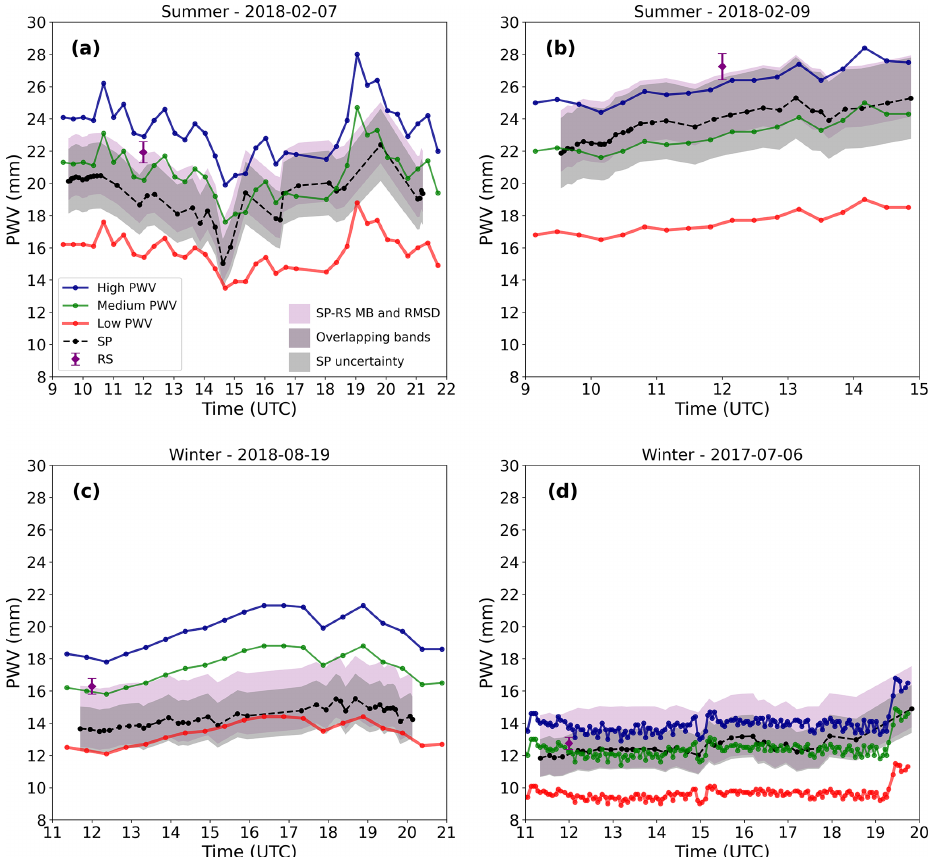
Figure 7. Examples of ASIVA PWV retrieval time series using synthetic profiles compared to AERONET sun photometer (SP, black) and radiosonde (RS, purple) for two summer days, ( a ) 7 February 2018 and ( b ) 9 February 2018, and two winter days, ( c ) 19 August 2018 and ( d ) 6 July 2017. The retrievals use the high-altitude (blue), medium-altitude (green), and low-altitude (red) simplified synthetic vertical profiles presented in Fig. 3 under the method described in Sect. 2.6. The darker gray shading indicates the nominal SP retrieval uncertainty of 10%. The RS error bar corresponds to a 3% uncertainty. The purple shading indicates the observed MB and RMSD when comparing SP and RS retrievals from Fig.